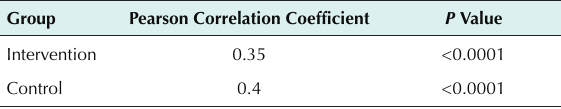
iejm.hums.ac.ir http